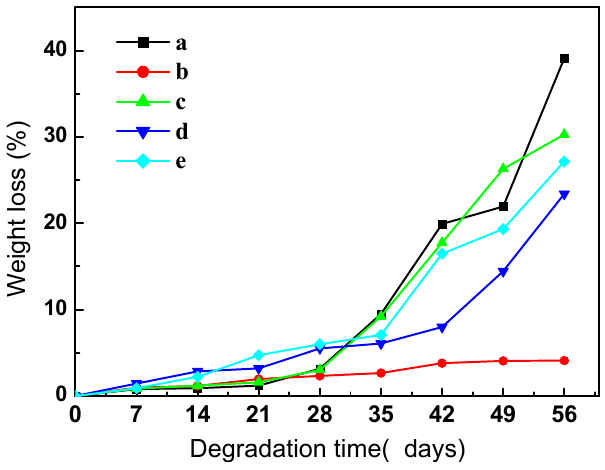
Figure 6. Weight loss of the examined samples as a function of degradation time: ( a ) PLA; ( b ) PBAT; ( c ) PLA/PBAT (80/20, w / w ); ( d ) PLA/PBAT/ADR (80/20/1, w / w ) and ( e ) PLA/PBAT/HDE (80/20/1, w / w ).